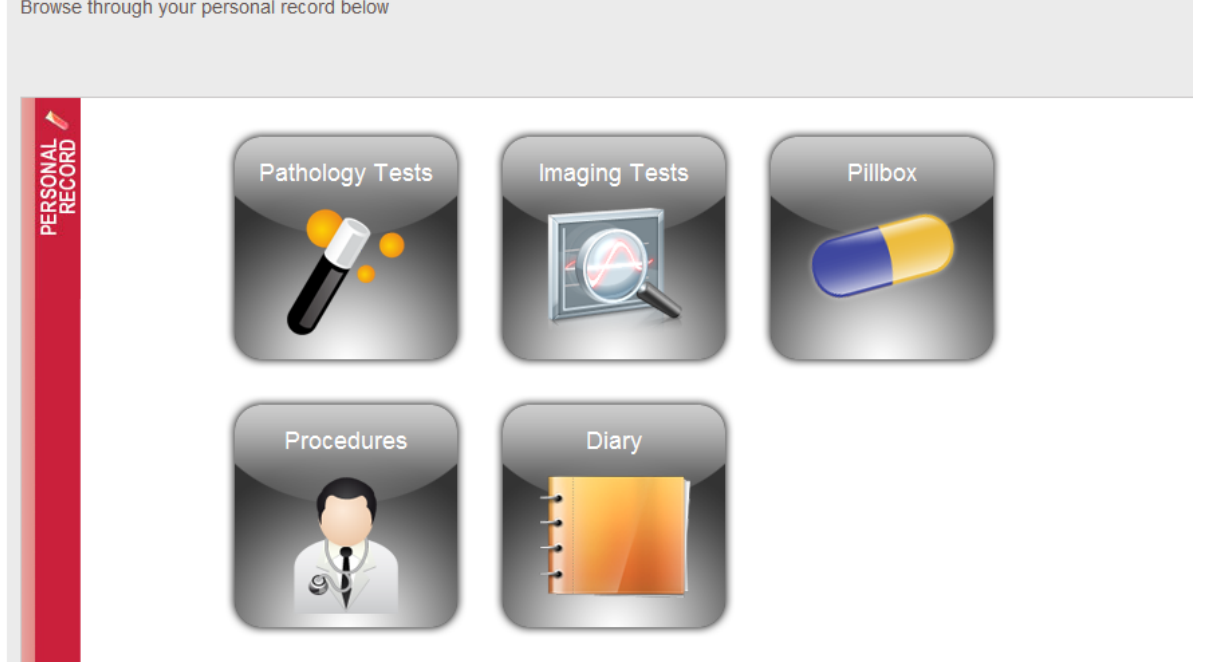
Figure 1. Personal Health Record on Healthy.me (University of New South Wales,